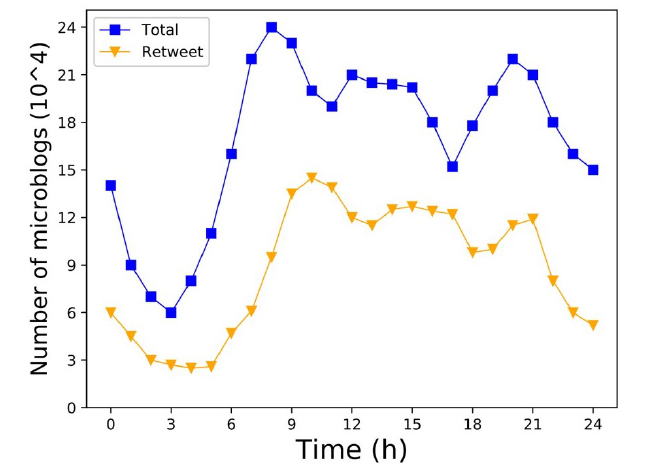
Figure 14. The influence of the publishing time of microblogs.